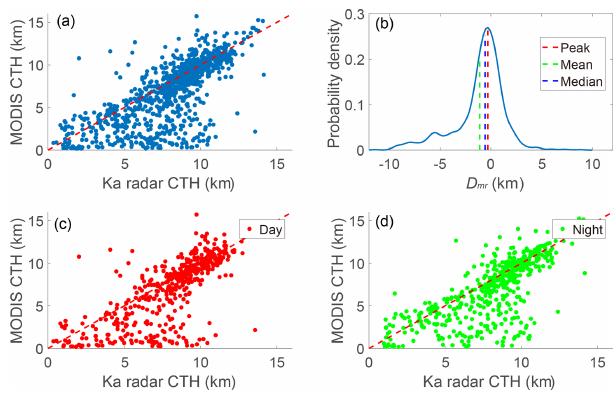
Figure 6. Scatter plot of MODIS CTHs and the Ka radar CTHs from (a) all comparisons, (c) comparisons at daytime and (d) com- parisons at night-time. Panel (b) shows the probability density dis- tribution of the D mr , and the peak, mean and median difference is illustrated with dashed red, green and blue lines, respectively.